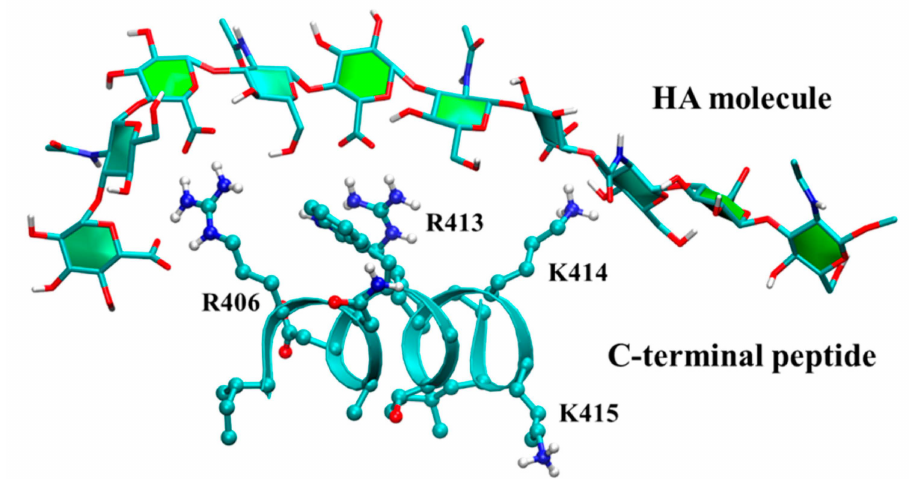
Figure 7. Molecular dynamics snapshot of a hyaluronan oligosaccharide interacting with the C- terminal region of Streptococcus equisimilis hyaluronan synthase. Probability densities computed from molecular dynamics snapshots show that R406 and R413 sidechains interact strongly with hyaluronan while the K414 sidechain interaction is weak. Reprinted with permission from reference [175], copyright 2017 American Chemical